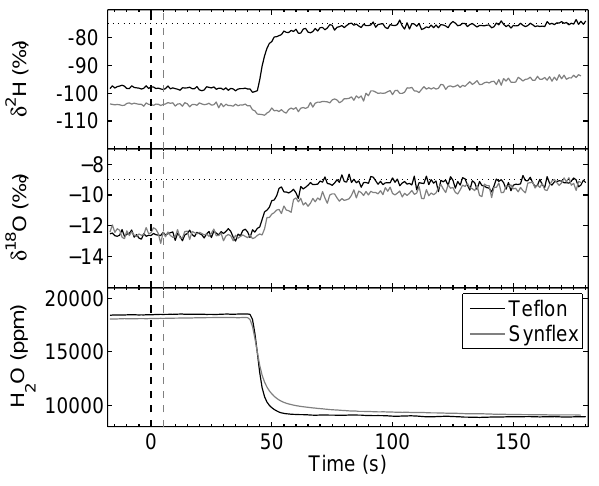
Fig. 6. Nonlinearity of δ 2 H (black dots, top) and δ 18 O (black dots, bottom) with changing H 2 O mixing ratio. For comparison results from water vapor generated by a dew point generator (DPG) are shown (grey dots, corrected for equilibrium and Rayleigh fraction- ation). The different range in δ -values for the dew point generator compared to the dripper is due to different source water that was used for this test. Water trapped at the outlet of the WVIA and mea- sured by IRMS (squares) is compared to the isotopic signature of the source water (dashed lines). Error bars of the IRMS measure- ments are smaller than the used